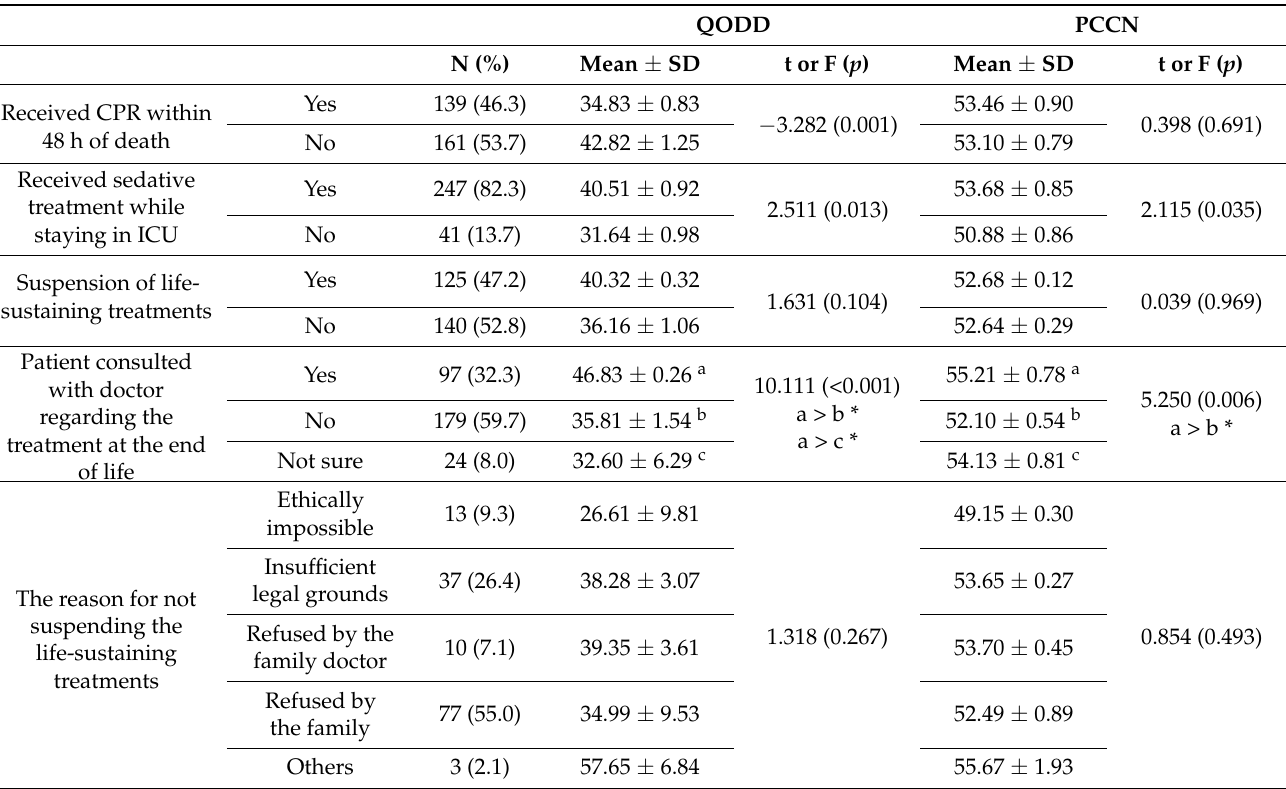
Table 2. QODD and PCCN, according to the patient’s treatment at the end of life (N = 300).